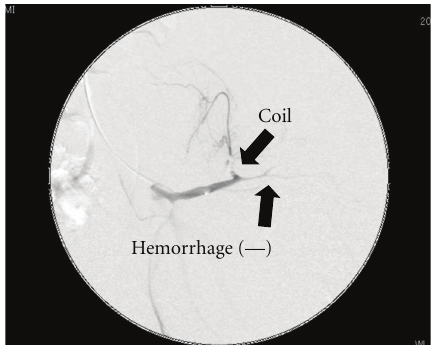
Figure 6: Postembolization angiography.